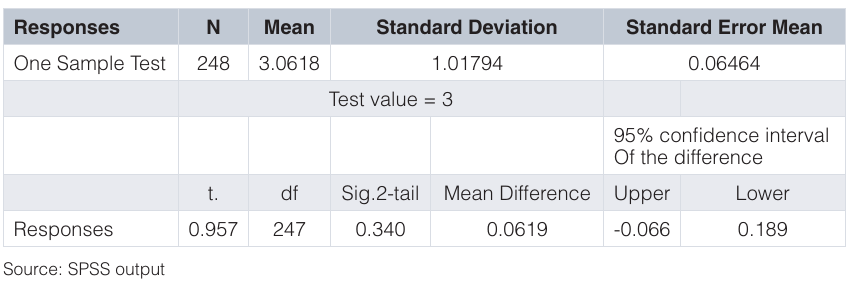
Table 4. Agricultural Extension Services of Edo Agricultural Development Programme (ADP) and development of infrastructural facilities.